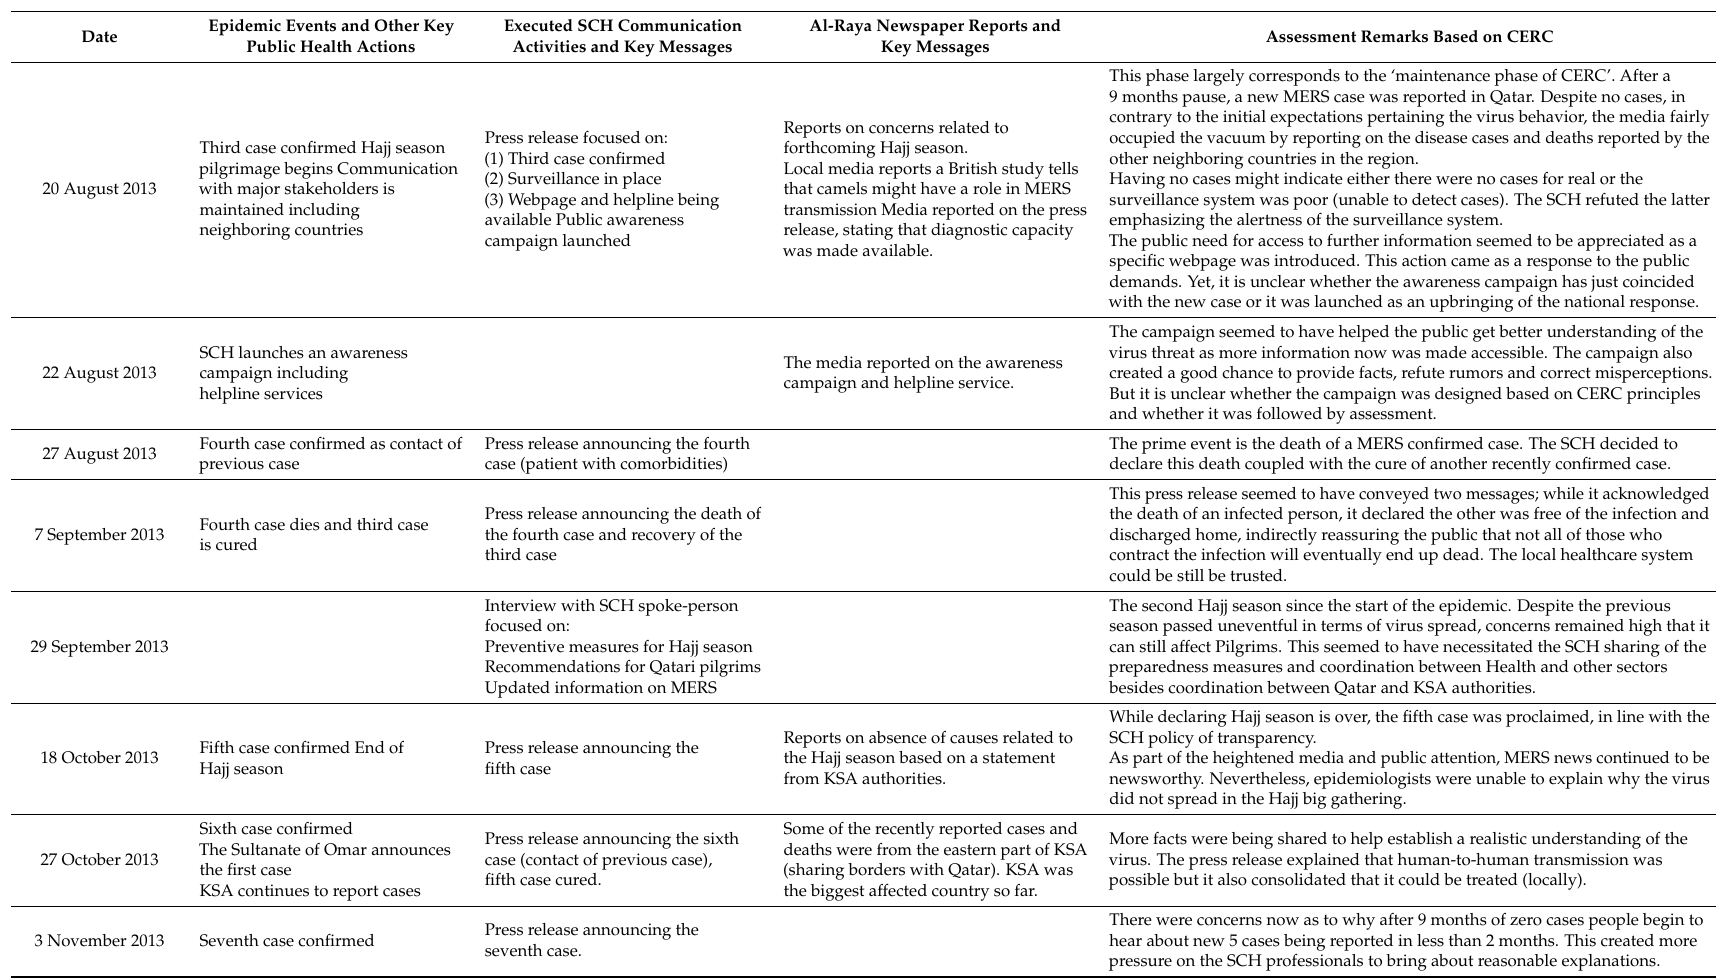
Table 3. Third phase of the epidemic (20 August 2013–17 March